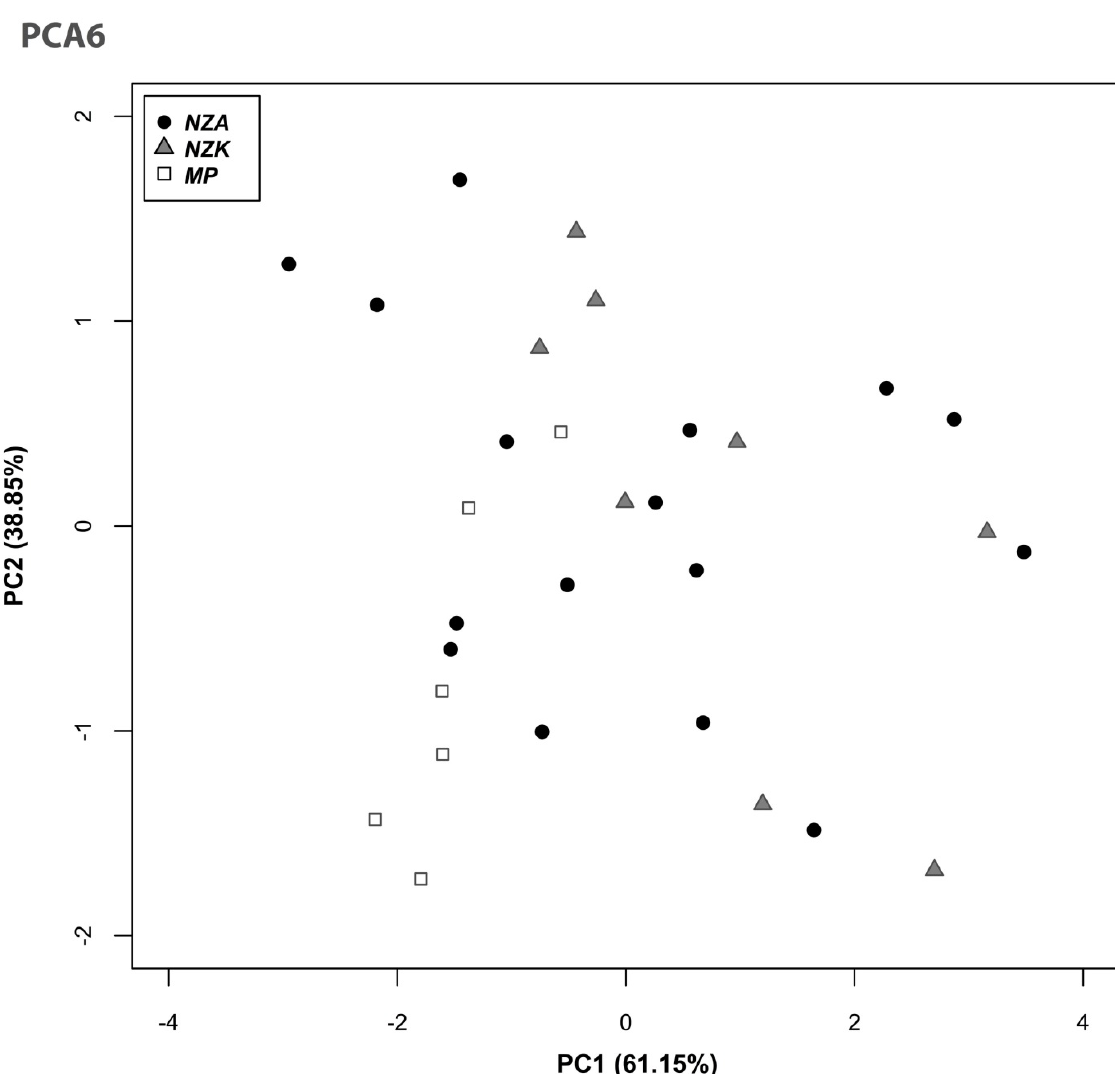
Figure 17. PCA6 - Plot of the PCA scores of the two PCs. PCA is realised on the three LSR variables. Results for this PCA are in Table 8 and concern only Lupemban points. Symbols represent sites (circles: NZA, triangles: NZK, squares: